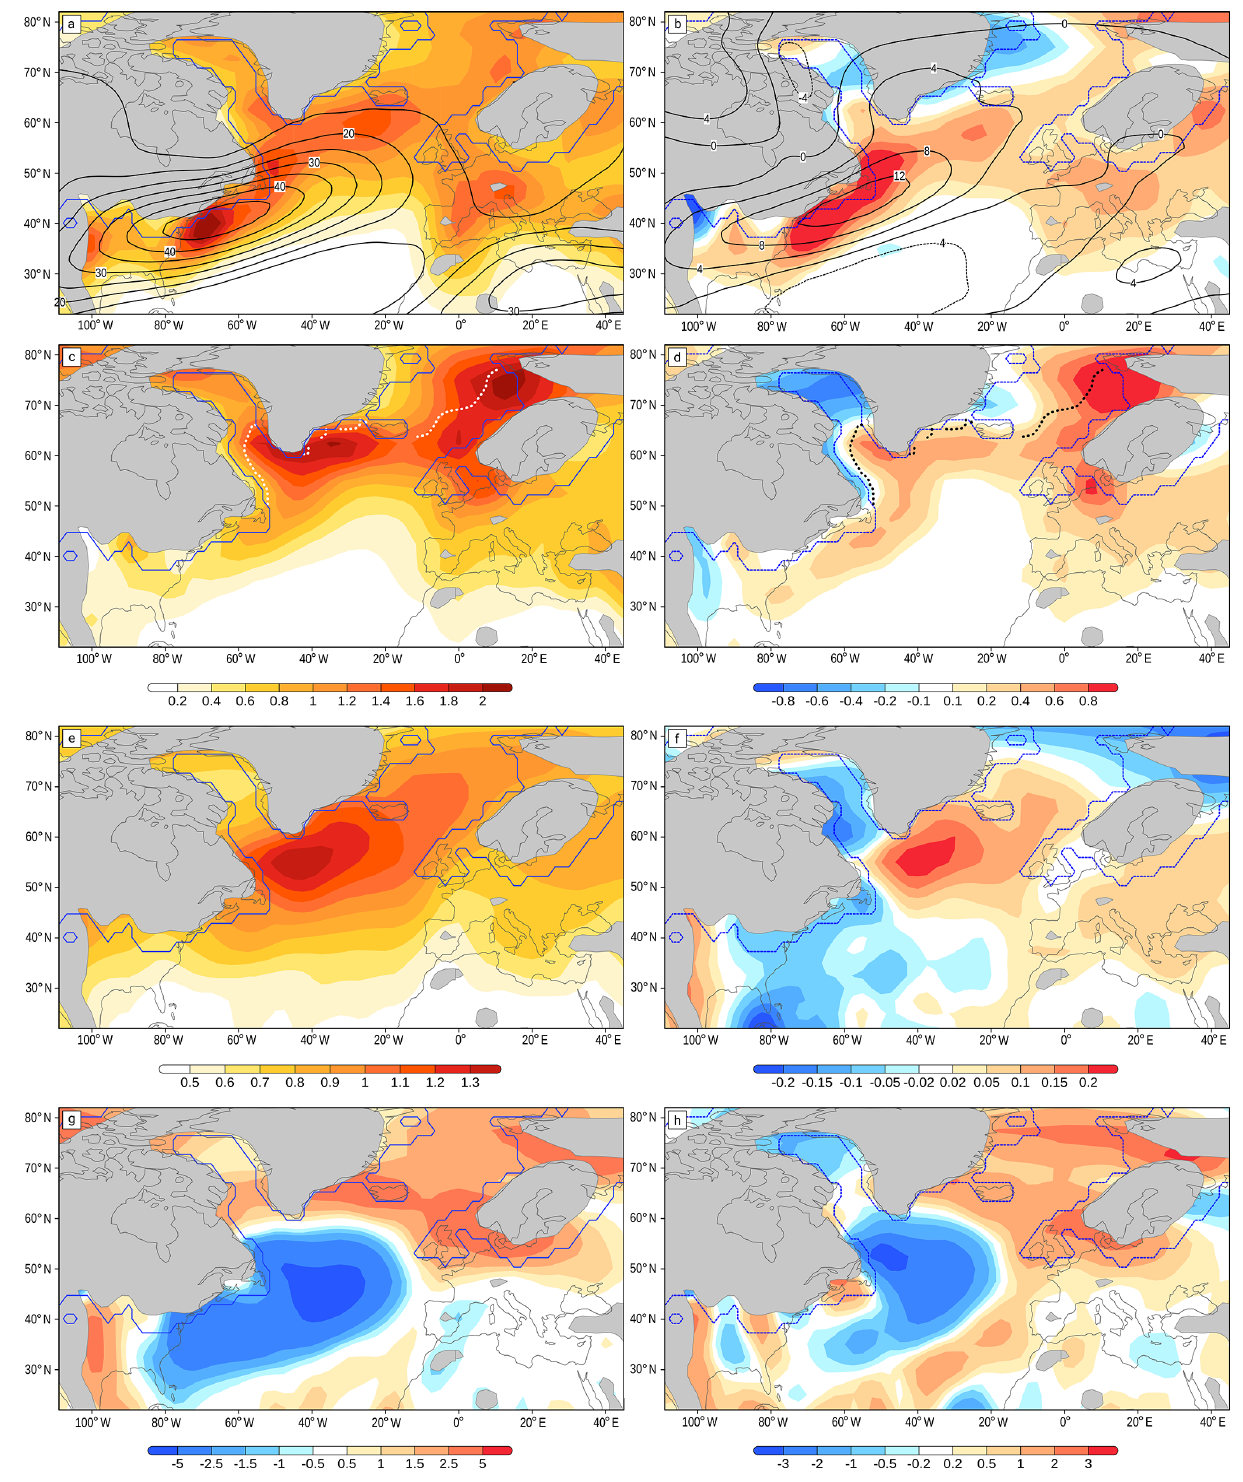
Figure 3. Statistical measures obtained from the cyclone-tracking algorithm for LGM cyclones (left column) and difference with PI cyclones (right column) for (a, b) cyclogenesis (events per extended winter per (deg.lat.) 2 ) (coloured) and wind speed at 300hPa (ms − 1 ) (contours); (c, d) cyclolysis (events per extended winter per (deg.lat.) 2 ); (e, f) mean (cid:49) MSLP (Laplacian of pressure per extended winter per (deg.lat.) 2 ) and (g, h) deepening rates (hPah − 1 ). Areas with topography higher than 1000m are shaded grey; ice sheet extent is marked by the blue line. Sea ice margin (>40% annual cover) in panels (c) and (d) is indicated by the bold dashed